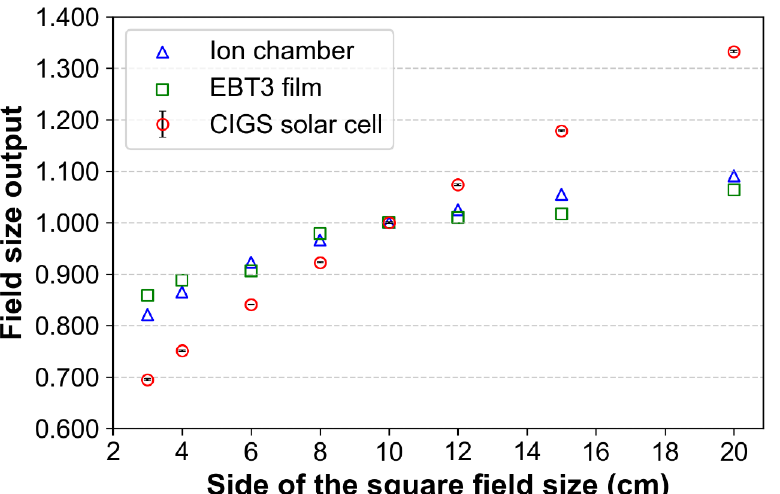
Figure 7. Field size output factors of copper indium gallium selenide (CIGS) solar cell, ion chamber, and film for various field sizes (3 × 3, 4 × 4, 6 × 6, 8 × 8, 10 × 10, 12 × 12, 15 × 15, and 20 × 20 cm 2 ) in 6 MV photon beams. The normalization was performed based on the output factor corresponding to a field size of 10 × 10 cm 2 . Error bars denote the standard deviations between three repeated measurements.